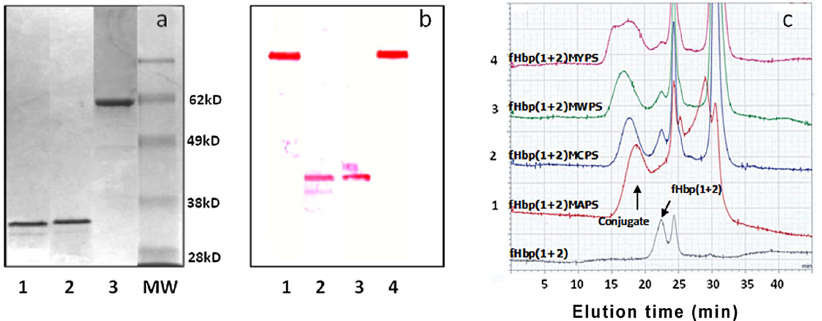
Figure 6. Analysis of purified fHbp variants and fHbp capsular conjugates. In Fig. 6a, is the Commassie Blue stained gel (10%) showing purified fHbp1 (Lane 1), fHbp2 (Lane 2) and fHbp(1 + 2) fusion product (Lane 3). In Fig. 6b is the Western blot analysis using mAbs Jar 5 (specific for fHbp1) and Jar 11 (specific for fHbp2); fHbp(1 + 2) in lanes 1 and 4 developed with mAbs Jar 5 and Jar 11 respectively; fHbp1 in lane 2 developed with mAb Jar 5, and fHbp2 in lane 3 developed with mAb Jar 11. In Fig. 6c are shown the HPLC profiles of fHbp(1 + 2) and the conjugate products fHbp(1 + 2)MAPS, fHbp(1 + 2)MCPS, fHbp(1 + 2)MWPS, fHbp(1 + 2)MYPS monitored at 280 nm.